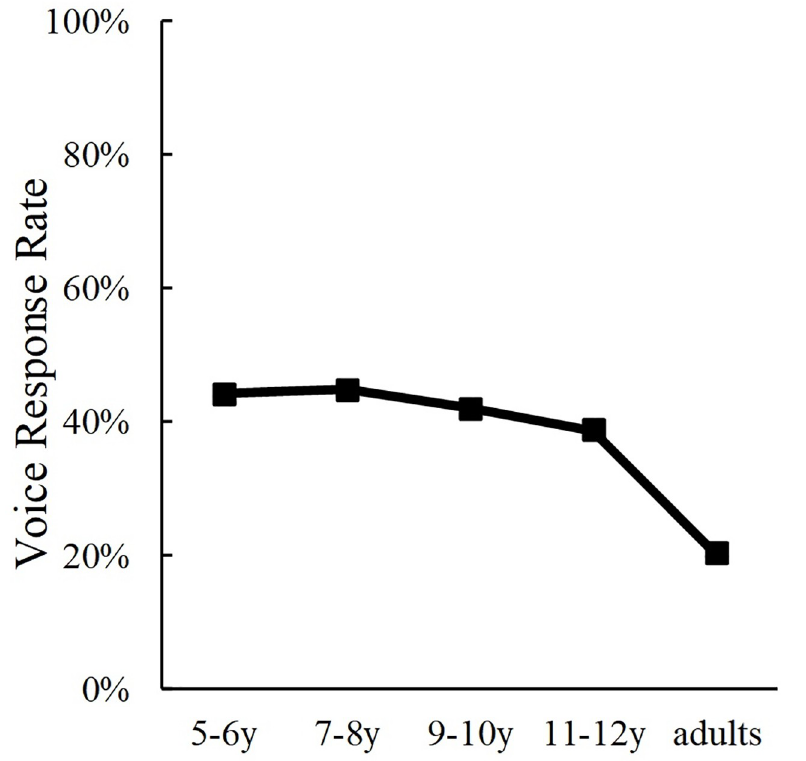
Fig 5. Developmental changes in auditory response rates in the phoneme perception